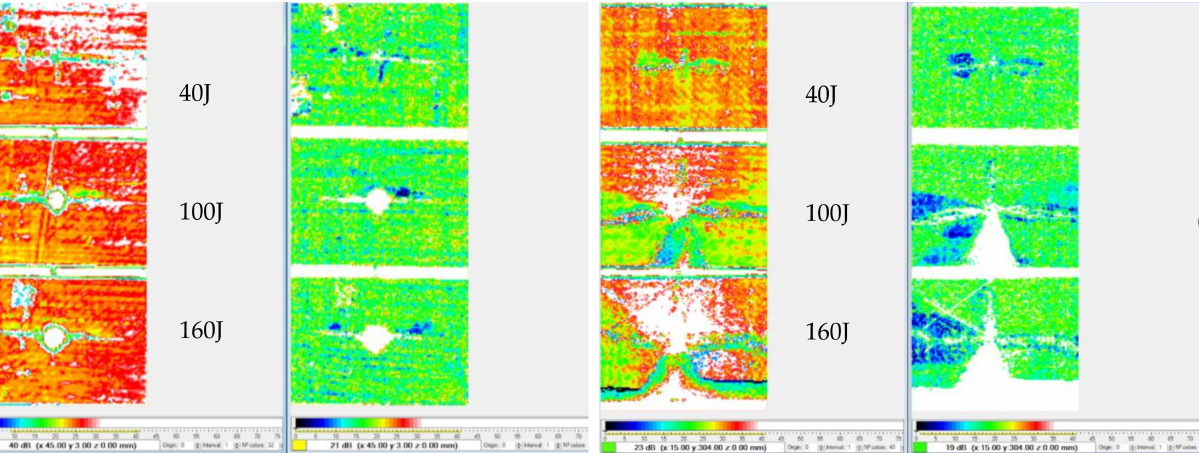
Figure 4. C-scans of the T700/PA6.6 ( left ) and T700/PPS ( right